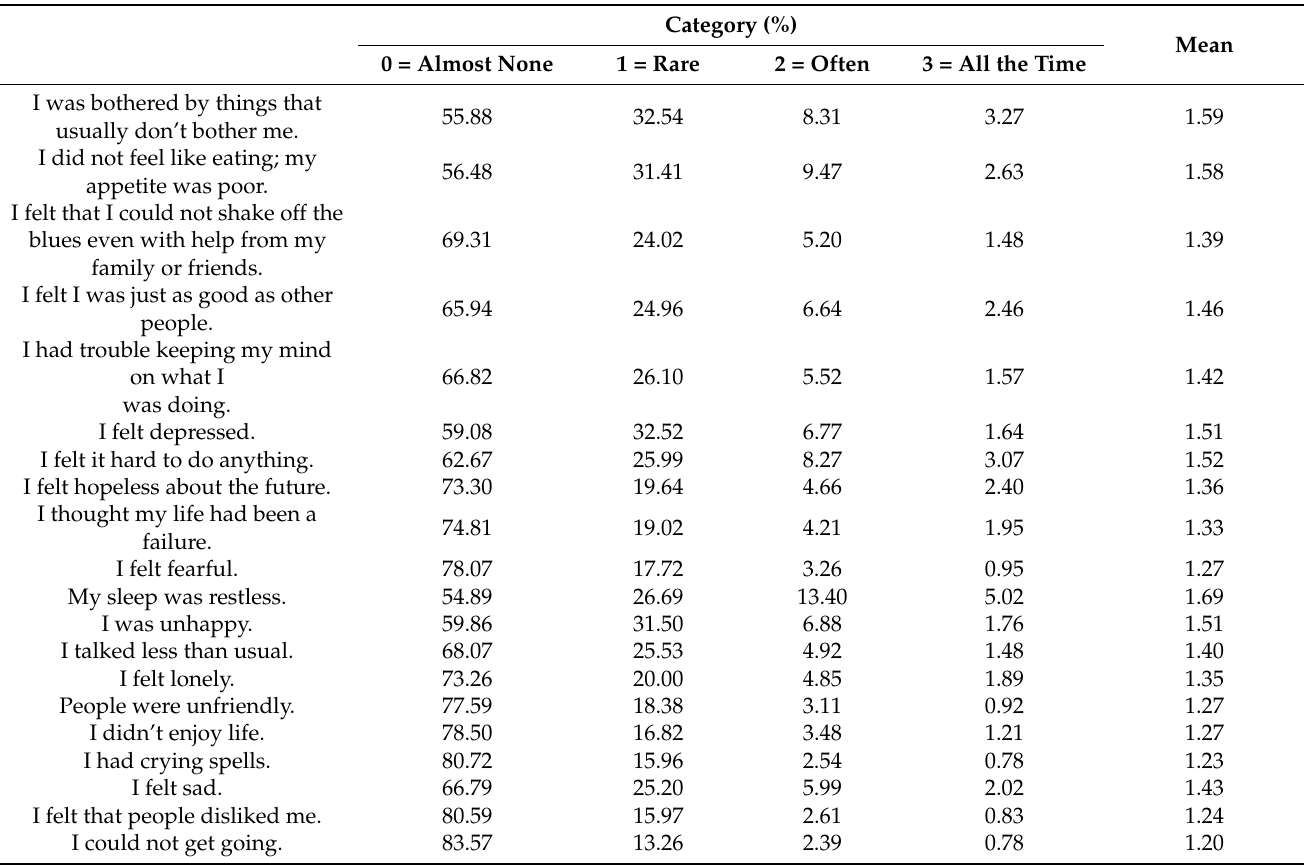
Table A1. Distribution of the sub-indexes of mental